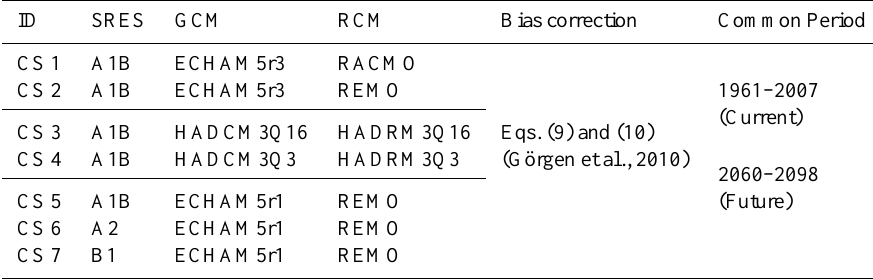
Table 2. Climate data availability and seven climate scenarios